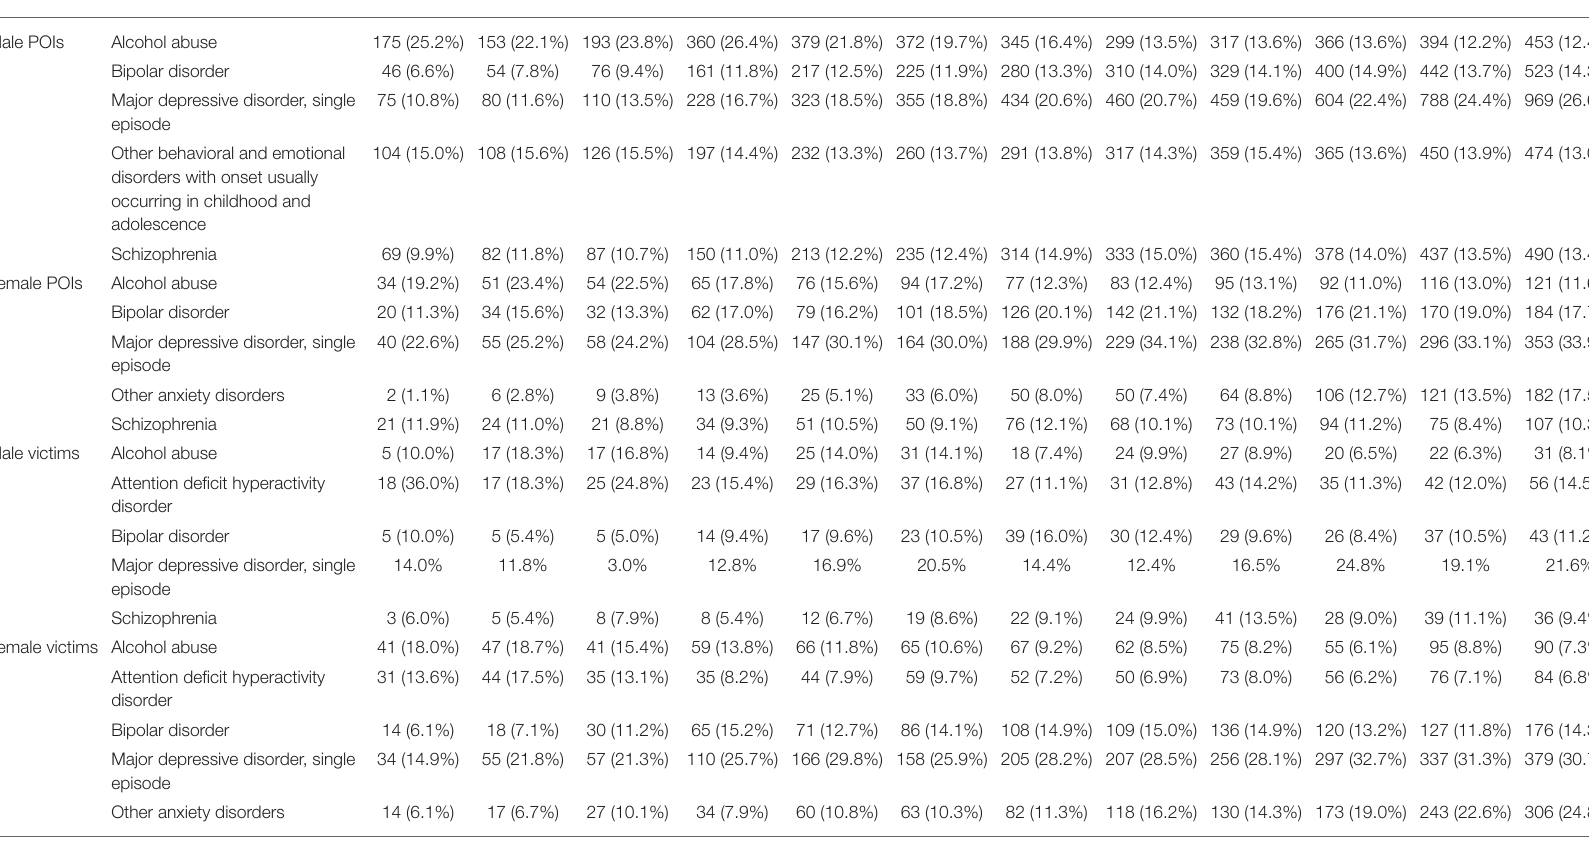
TABLE 1 | Number and trends in the proportion of events with the most common mental illnesses for male and female POIs and victims in 416,441 police recorded domestic violence events that occurred in residential premises in NSW, January 2005–December 2016. Mental